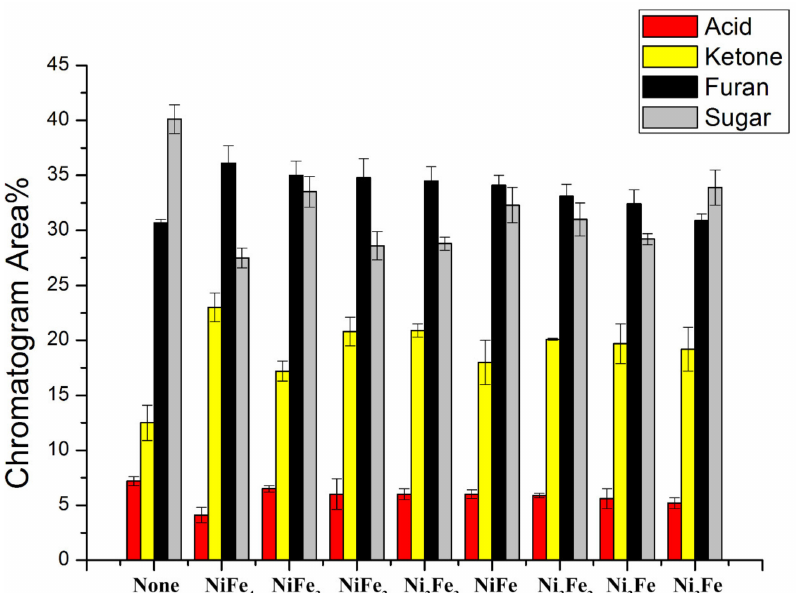
Figure 8. Chemical relative compositions of the organic phase of bio-oils prepared with di ff erent cluster structural